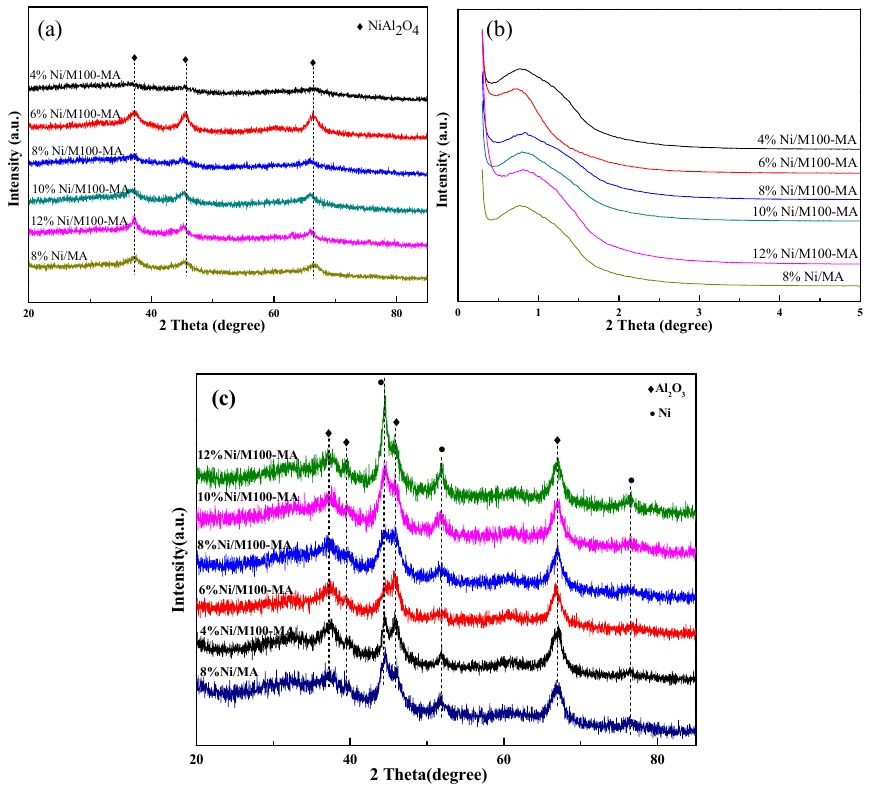
Figure 2. Wide-angle XRD patterns ( a ) and low-angle XRD patterns ( b ) of the calcined samples; ( c ) wide-angle XRD patterns of the reduced samples.